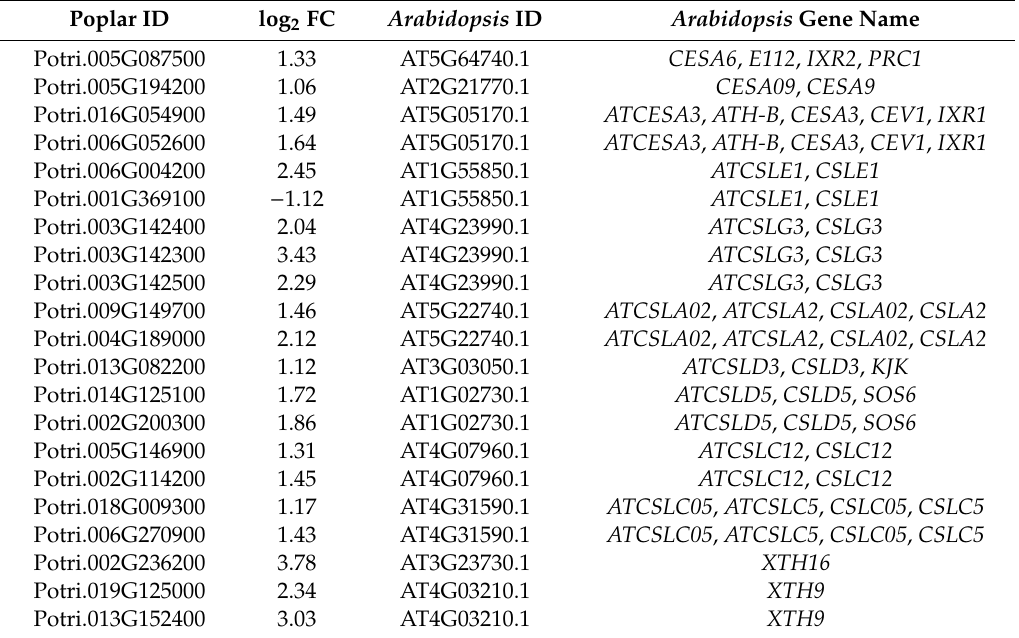
Table 1. Di ff erentially expressed genes involved in PCW formation and modification in 21 dai galls versus uninfected